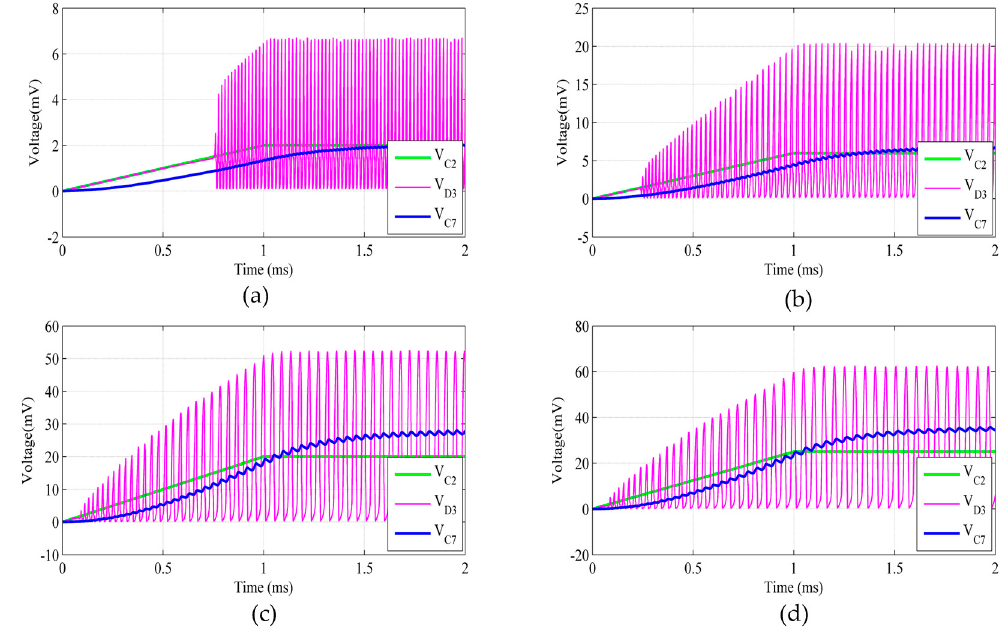
Figure 10. The simulation result at the three most important testing points for the proposed power processing circuit when V AC is ( a ) 2 mVp-p, ( b ) 6 mVp-p, ( c ) 20 mVp-p and ( d ) 35 mVp-p.